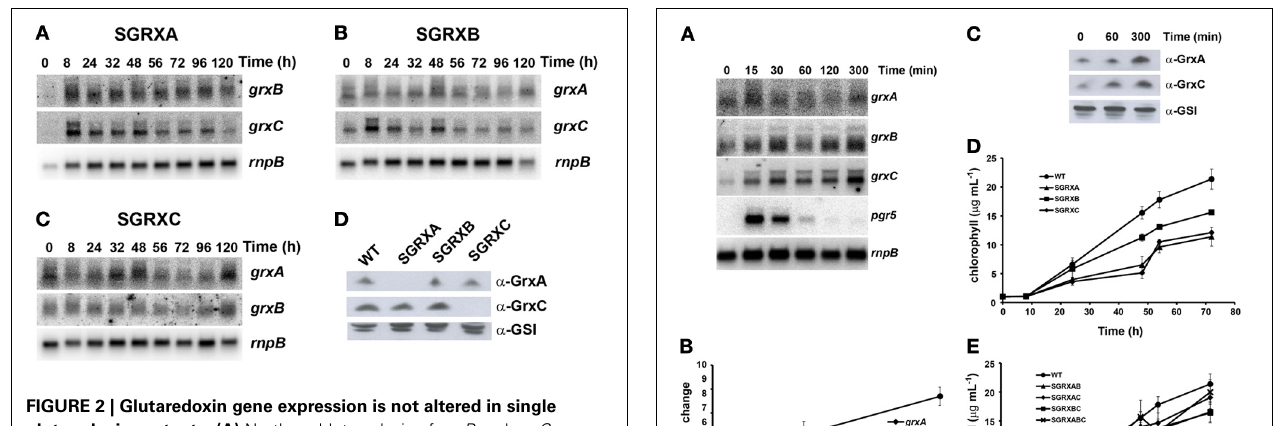
FIGURE 2 | Glutaredoxin gene expression is not altered in single glutaredoxin mutants. (A) Northern blot analysis of grxB and grxC expression during different stages of the growth curve in SGRXA. Total RNA was isolated from SGRXA cells grown in BG11C at the indicated times. The filter was hybridized with grxB and grxC probes and subsequently stripped and re-hybridized with an rnpB probe as a control. (B) Northern blot analysis of grxA and grxC expression during different states of the growth curve in SGRXB. Total RNA was isolated from SGRXB cells grown in BG11C at the indicated times. The filter was hybridized with a grxA and grxC probes and subsequently stripped and re-hybridized with an rnpB probe as a control. (C) Northern blot analysis of grxA and grxB expression during different states of the growth curve in SGRXC. Total RNA was isolated from SGRXC cells grown in BG11C at the indicated times. The filter was hybridized with a grxA and grxB probes and subsequently stripped and re-hybridized with an rnpB probe as a control. (D) Western blot analysis of GrxA and GrxC levels in glutaredoxin mutants. WT, SGRXA, SGRXB, and SGRXC cells were grown in BG11C medium and cells were harvested at exponential phase (3–5 μ g chl mL − 1 ). Fifteen microgram of total protein from soluble extracts were separated by 15% SDS-PAGE and subjected to western blot to detect GrxA, GrxC, and GSI.